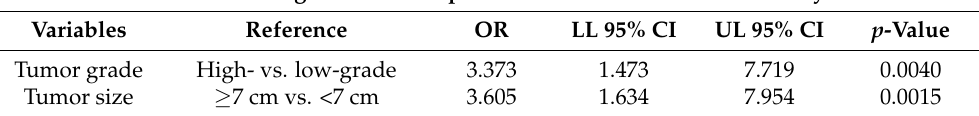
Table 6. Multivariate analyses of factors predictive for recurrence-free survival in patients with clear cell renal cell carcinoma